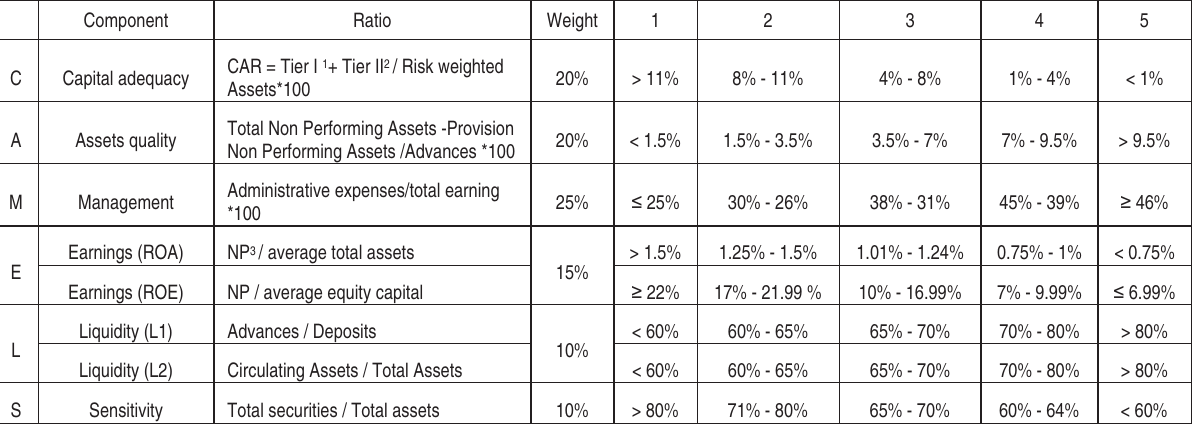
Table 4. Evaluation under CAMELS rating system